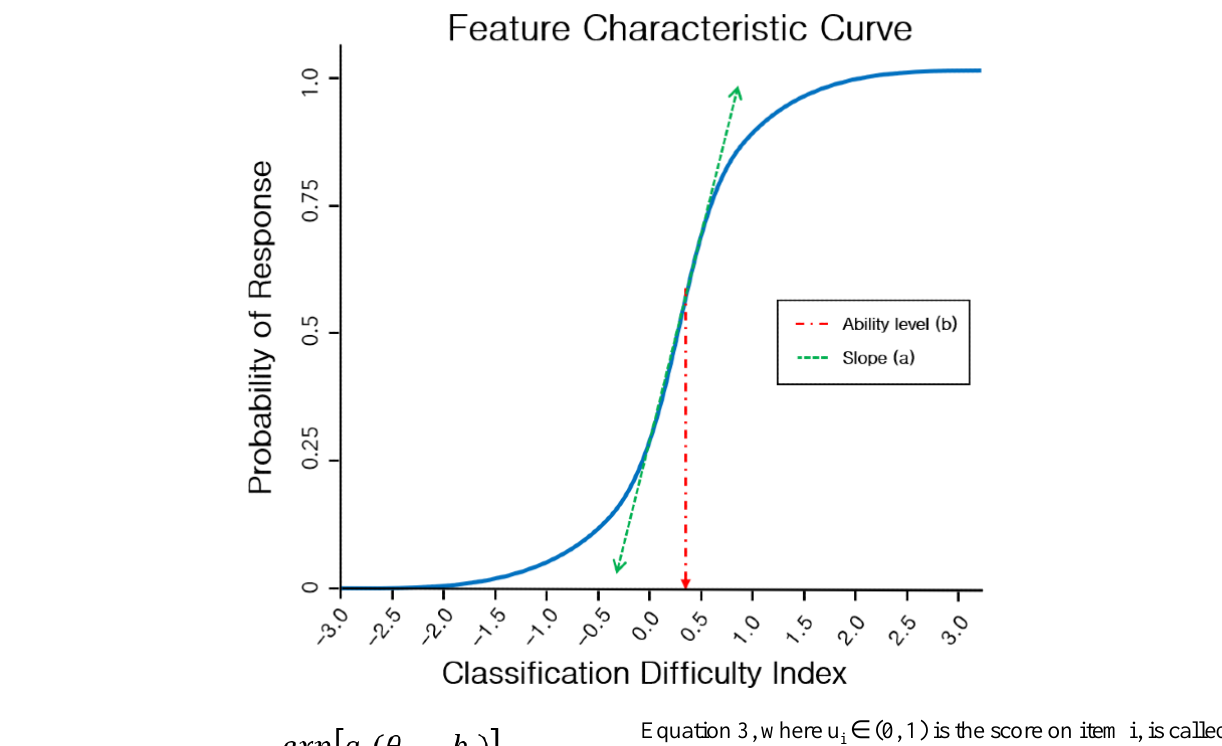
Figure 1. Characteristic curve using a 2-parameter logistic